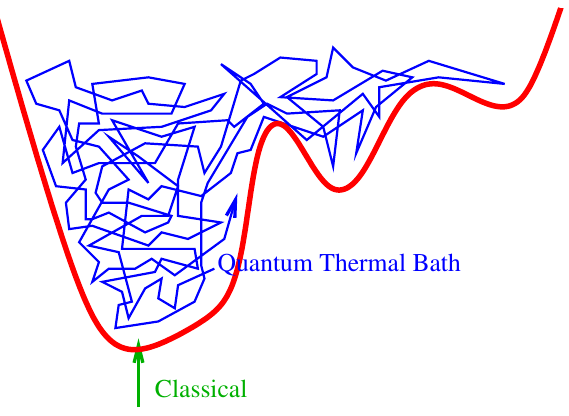
Figure 6. The QTB introduces a stochastic trajectory (blue) to account for quantum delocalization, while a classical particle (green) will remain at the bottom of the potential well (at temper- ature 0K). The dynamics remains formally classical but produces a quantum correction to the positional